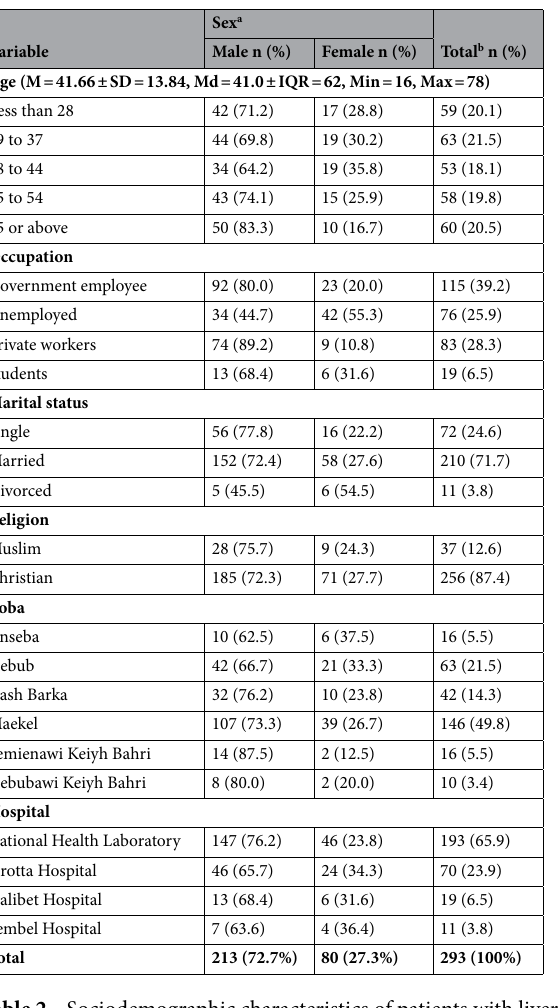
Table 2. Sociodemographic characteristics of patients with liver disease (n = 293). a Percentage is computed from the row total. b Percentage is computed from total liver